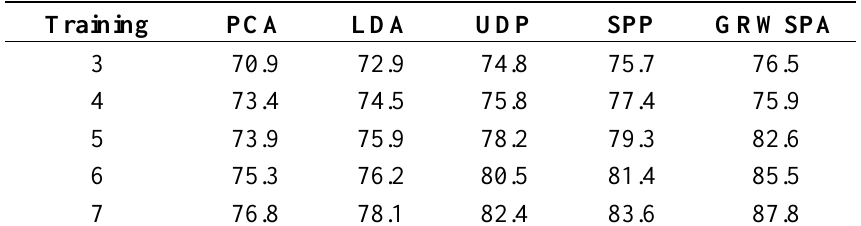
Table 2. Recognition Rates on